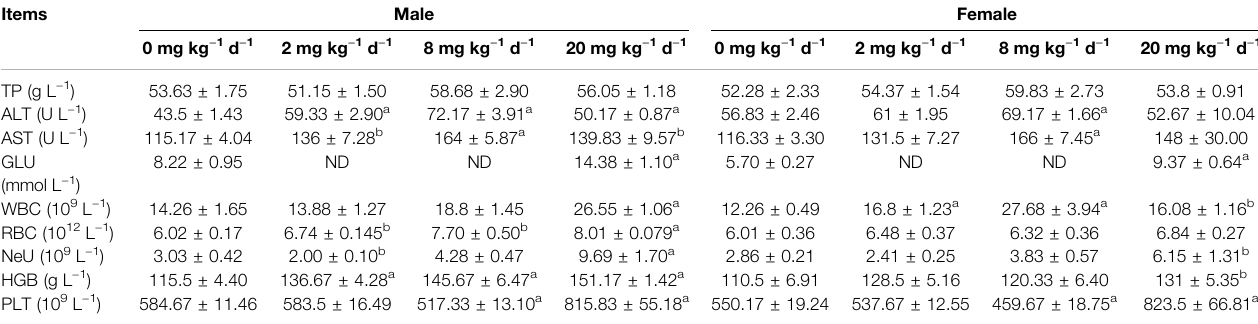
TABLE 3 | Hematology and serum biochemical values of rats following oral administration of ATO for 28 days.